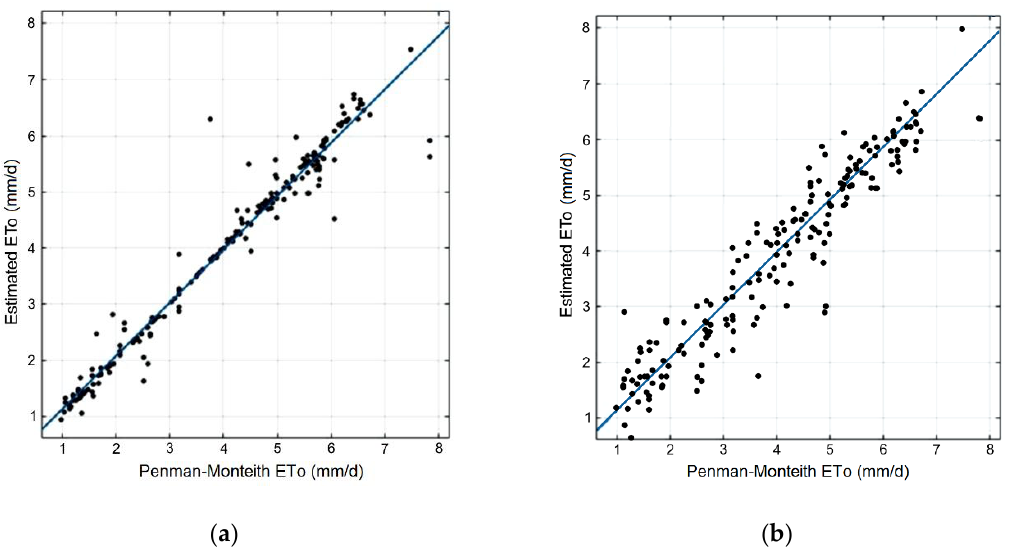
Figure 6. Scatter plots of the reference evapotranspiration (ETo) obtained with the Penman–Monteith method, and the generated predictions using the dataset at 6-h intervals removing sensor 3, applying the two best models. ( a ) randomizable filtered classifier and K* algorithm; ( b ) artificial neural network.